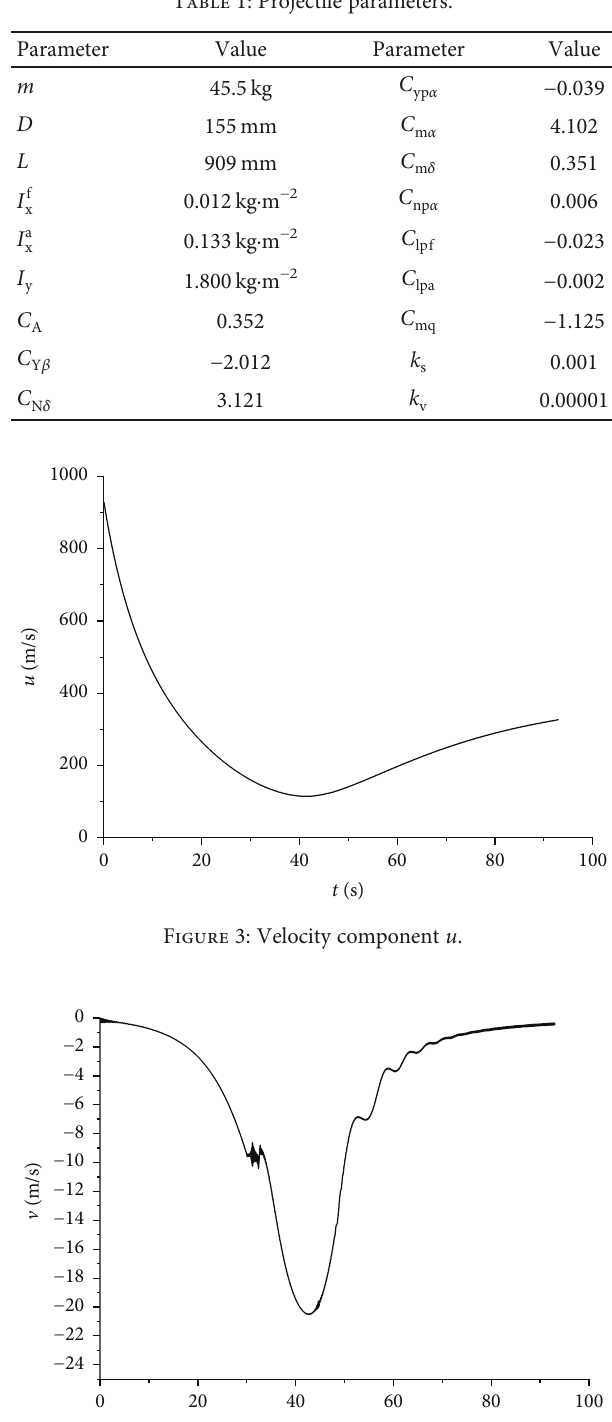
Table 1: Projectile parameters.